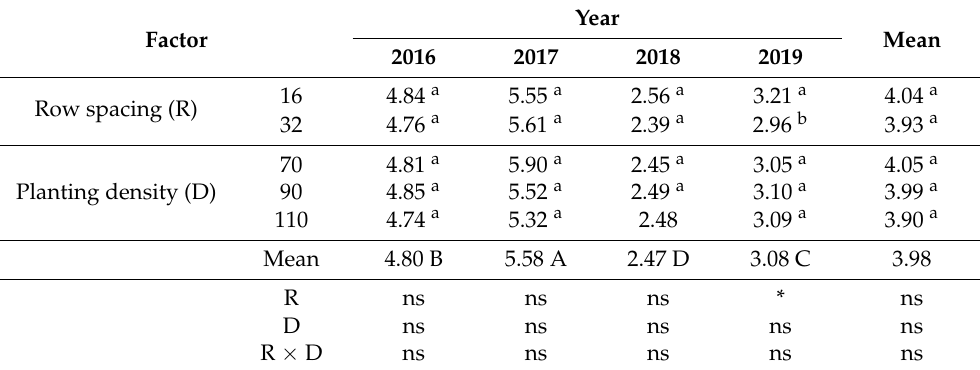
Table 3. Effect of row spacing and planting density on the pea seed yield (t · ha − 1 ) in 2016–2019.